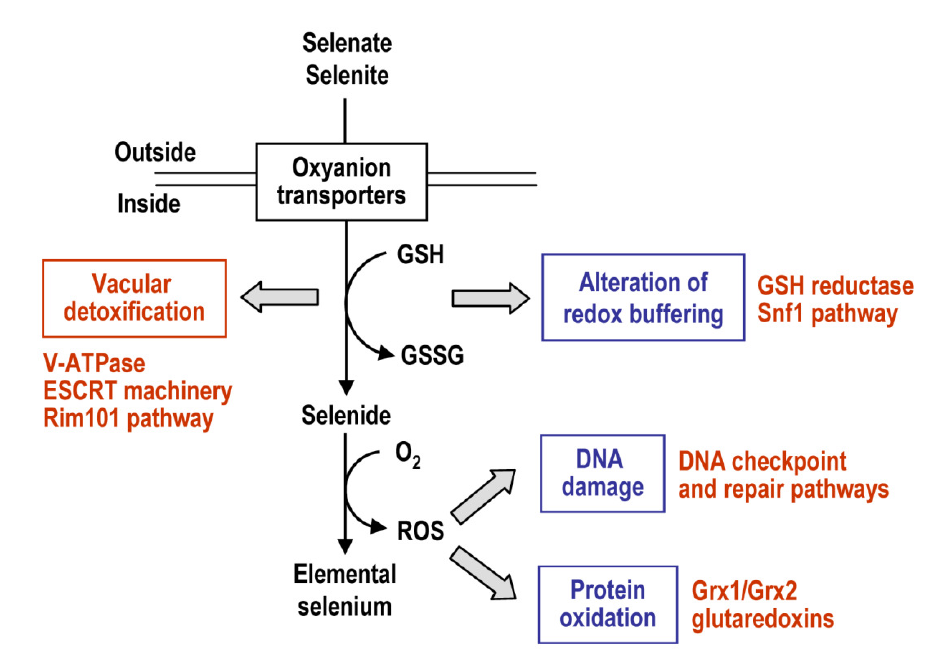
FIGURE 2: Description of factors and pathways involved in the uptake, intracellular selenium tolerance and detoxification in S. cere- visiae . See the text for details. Toxic consequences (blue) and protective mechanisms (red) are